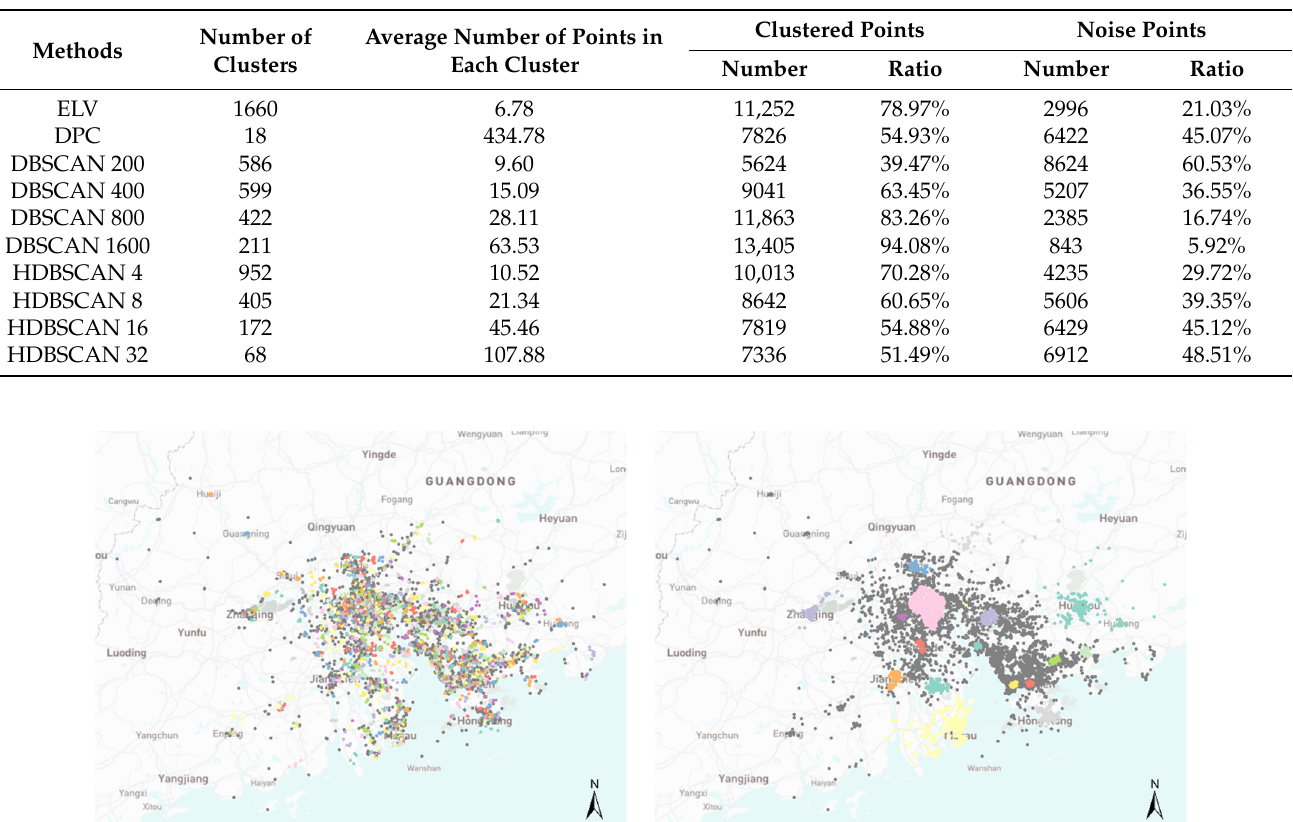
Table 3. Statistical information of the different methods tested on the first-day data in the GBA dataset.